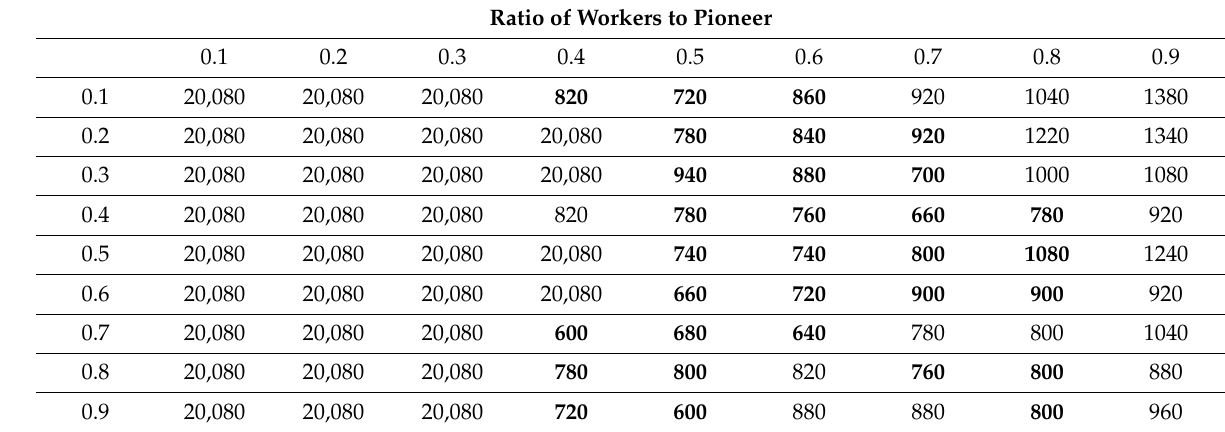
Table 1. Average NOFE with different parameter settings in the Perm function (100 D).